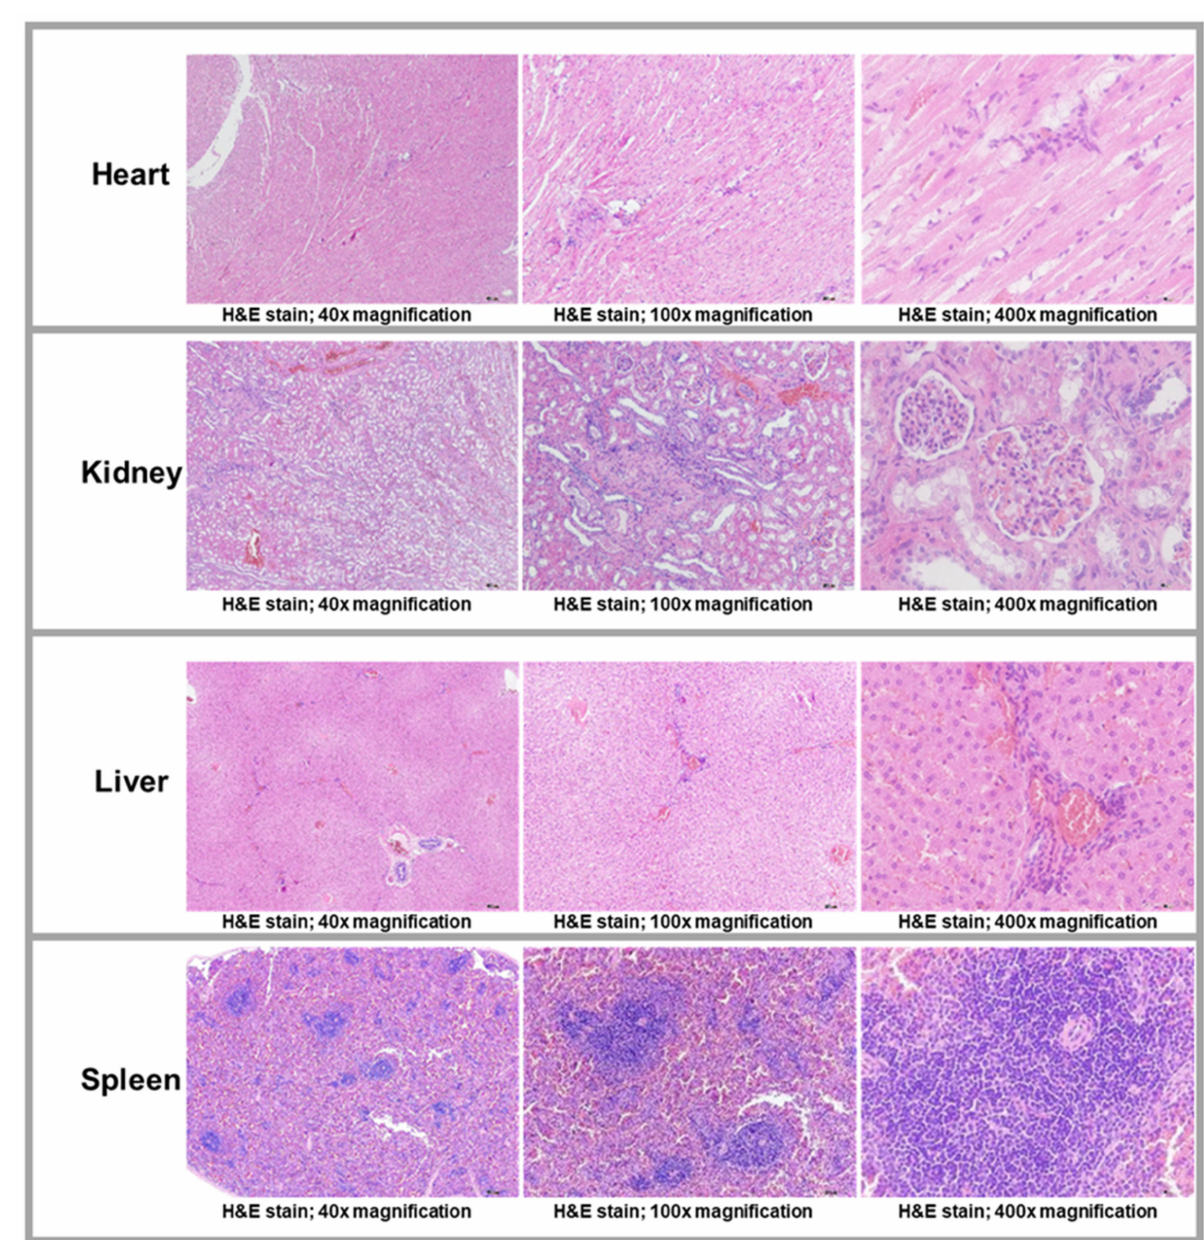
Figure 8. Histopathological examinations of visceral organs (heart, kidney, liver, and spleen). The specimens were obtained from one of the animals implanted with an iron bioabsorbable triple-helix suture anchor. Scale from 40 × , 100 × , and 400 × , respectively. H&E stain: hematoxylin and eosin